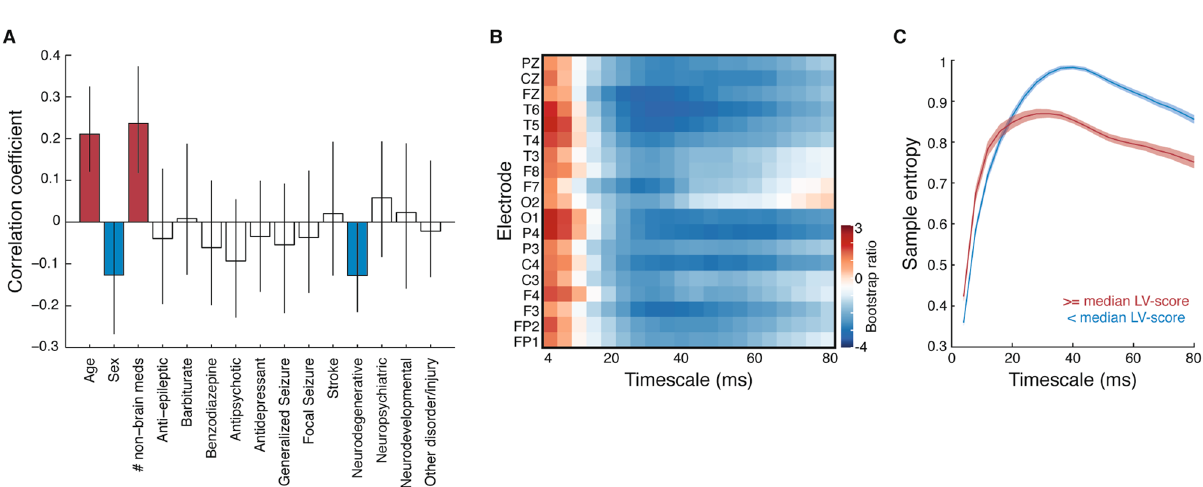
Figure 3. Brain signal complexity differs for older unhealthy males. Correlation coefficients ( A ) and bootstrap ratios ( B ) of the second latent variable relating clinical data to MSE curves. ( C ) Average (± SEM) MSE curves, with subjects split into two groups according to their LV-scores. MSE curves were first averaged across electrodes within subjects, then averaged across subjects within each group. In ( A ), variables whose coefficients are significantly different from 0 are indicated in color for ease of interpretation. Figure panels created in MATLAB v.9.1 and merged using Adobe Illustrator